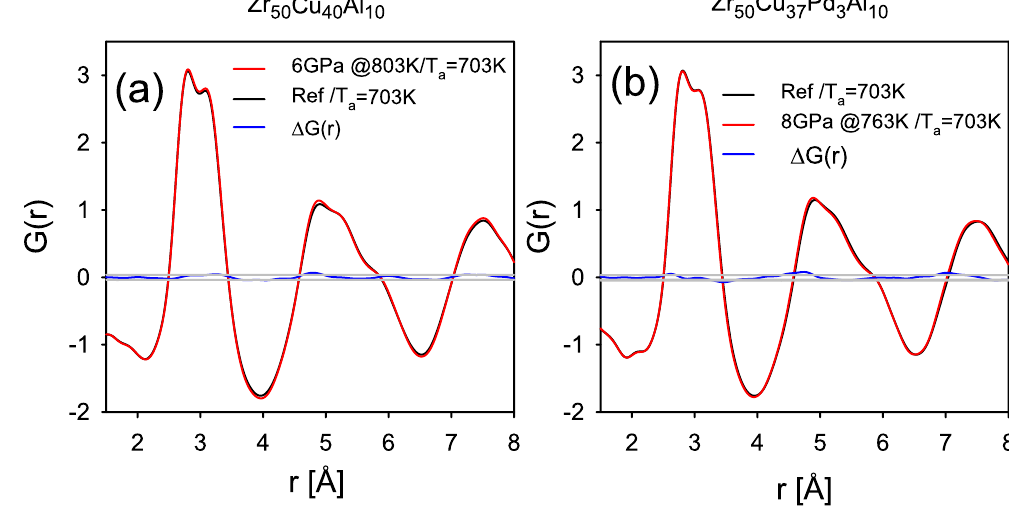
Figure 6. ( a , b ) The G ( r ) for the samples that were quenched under high pressure from the SCL, and then annealed at ambient pressure 5 degrees below the glass transition temperature. The reference (as cast) samples were also annealed at the same temperature for the comparison.